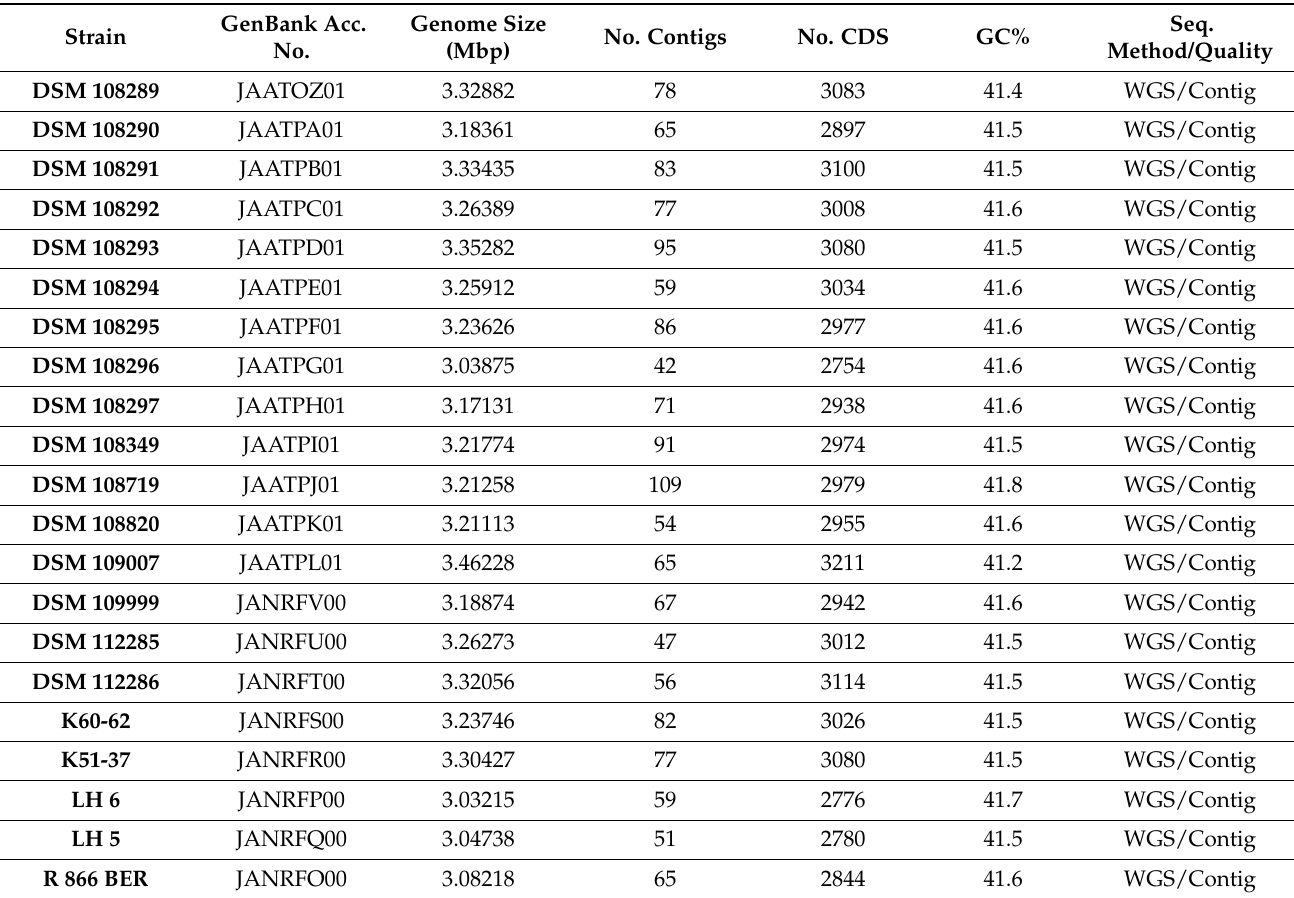
Table 3. Genome data of all A. radioresistens strains sequenced within this